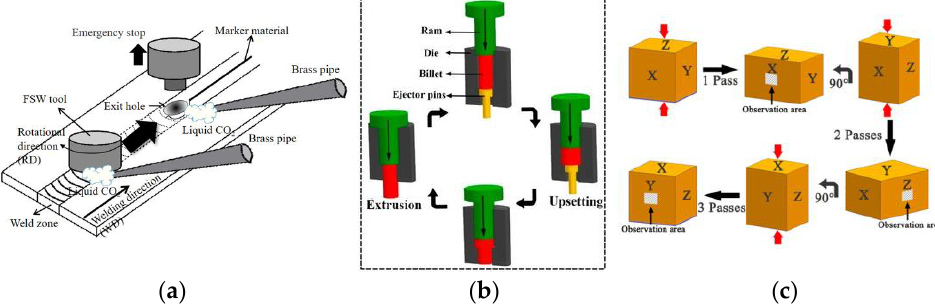
Figure 1. Schematic representations of some processes used to prescribe large-strain hot deformations: ( a ) friction stir welding [5]; ( b ) reciprocating upsetting-extrusion [6]; ( c ) multidirectional forging [7]. Nagira et al.’s paper [5] investigates the DRX of both commercial-grade and high- purity aluminium occurring during friction stir welding; possible transitions between DDRX and CDRX are revealed, which are associated with distinct texture components. Dolzhenko et al.’s article [8] deals with DRX in an austenitic stainless steel containing about 10 vol% ferrite together with a small fraction of nanometric Z-phase (CrNbN) particles sub- mitted to compression tests. Power-law functions are used to relate the various mechanical and microstructural parameters to each